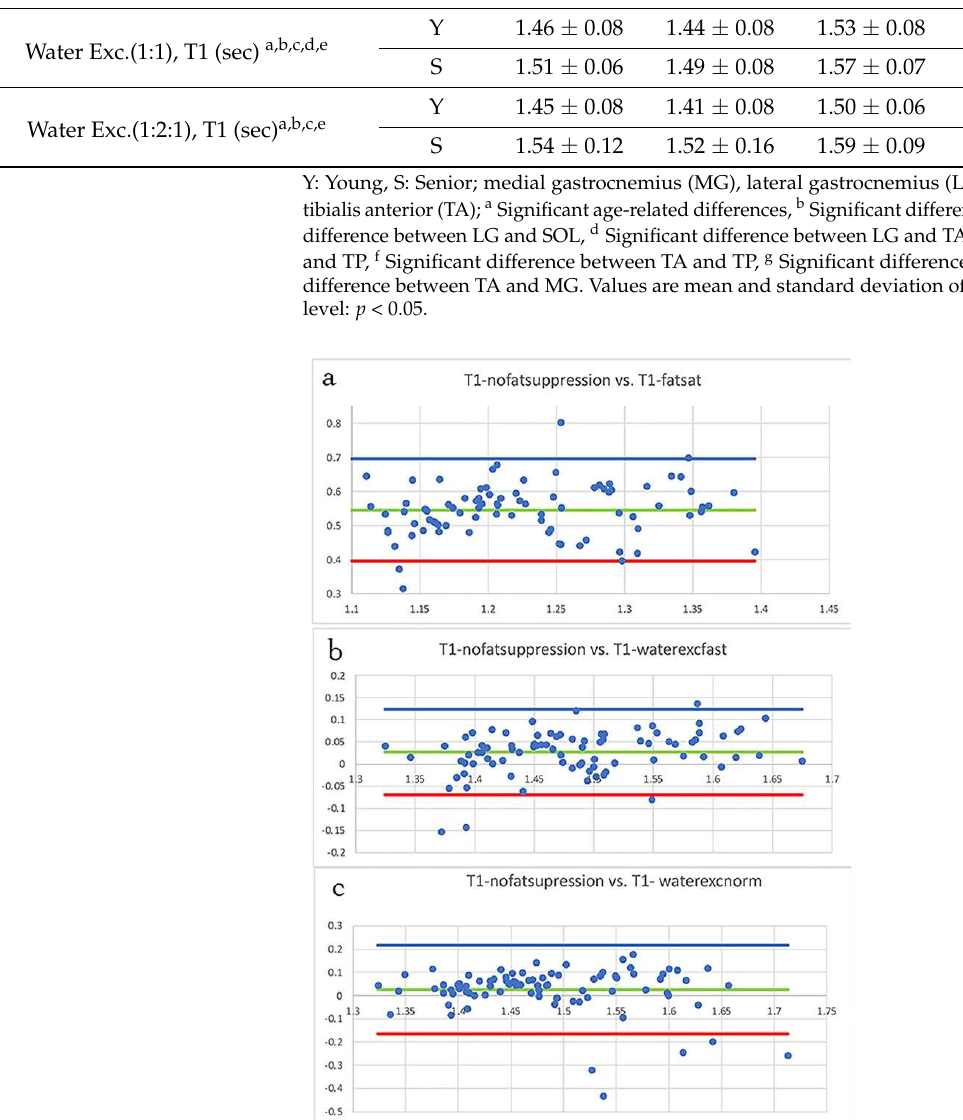
Figure 2. Bland–Altman plot of the difference in T1 values between two measurements (with fat suppression and the reference, without fat suppression) vs. the mean of the two measurements (young subjects only). The y -axis is the difference in T1 values between images with and without fat suppression, the x -axis is the mean of the two measurements. The data points are T1 values derived from ROIs in each muscle for the ten young subjects. The 95% confidence lines are indicated by the blue and red lines, while the green line is the bias. Using the fat unsuppressed sequence as the reference, BA plots are shown for T1 from the fat saturated sequence ( a ), the water excitation sequence using 1:1 composite pulse ( b ), and the water excitation sequence using 1:2:1 composite pulse ( c